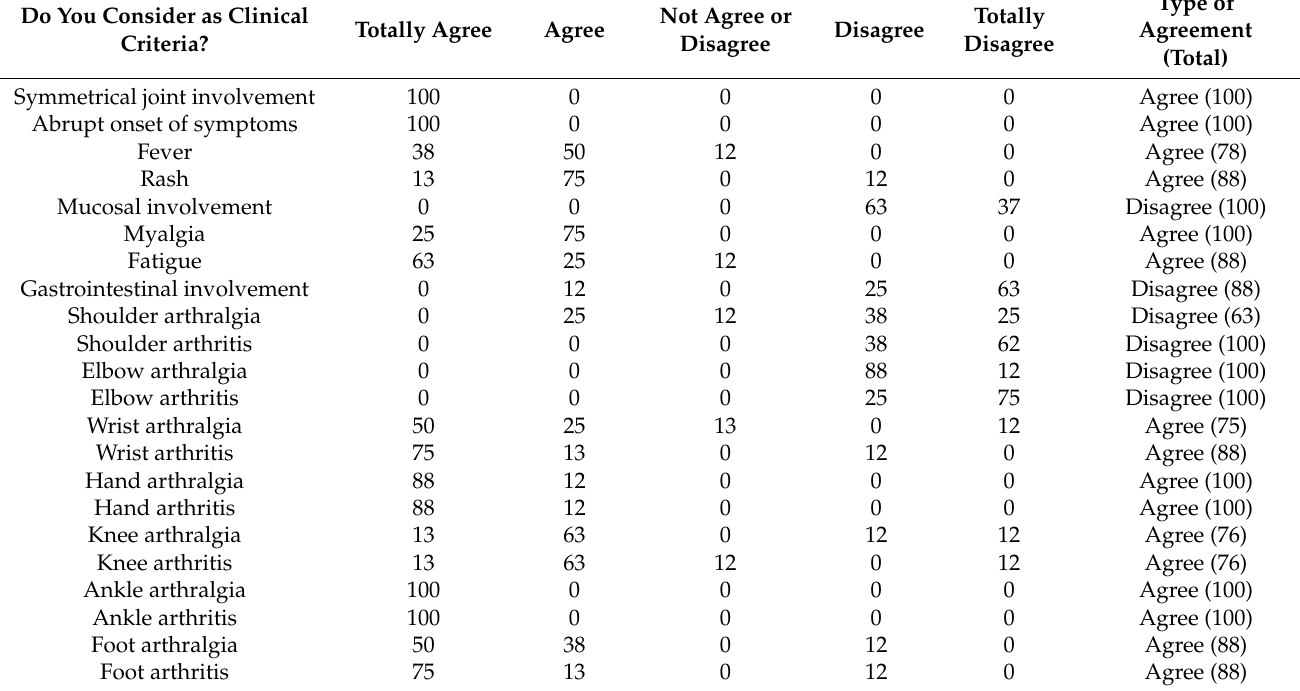
Table 3. Agreement percentage to formulated questions on CHIKV clinical characteristics.